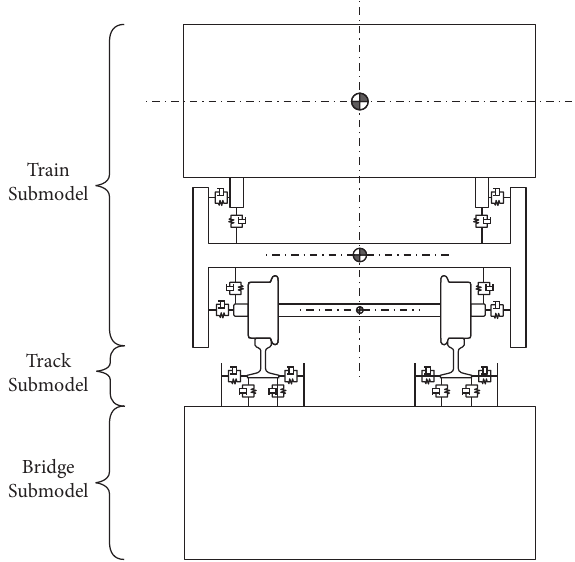
Figure 2: Train-track-bridge coupled dynamic